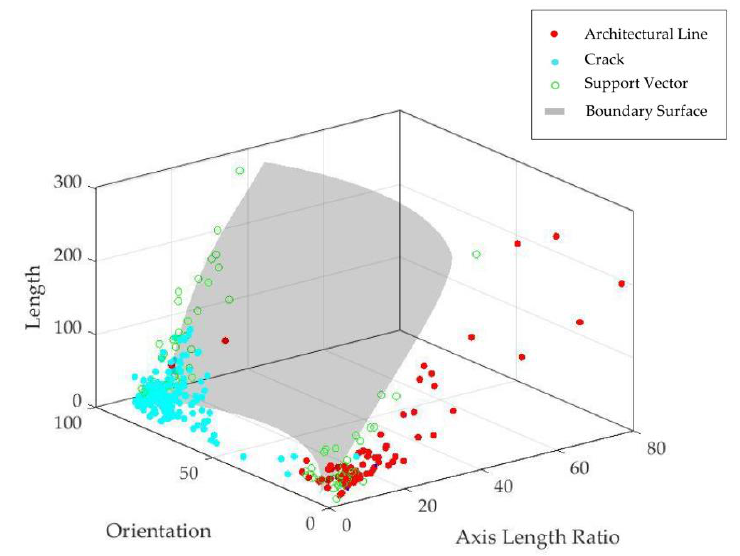
Figure 13. Sensitivity of the model to three fundamental parameters.